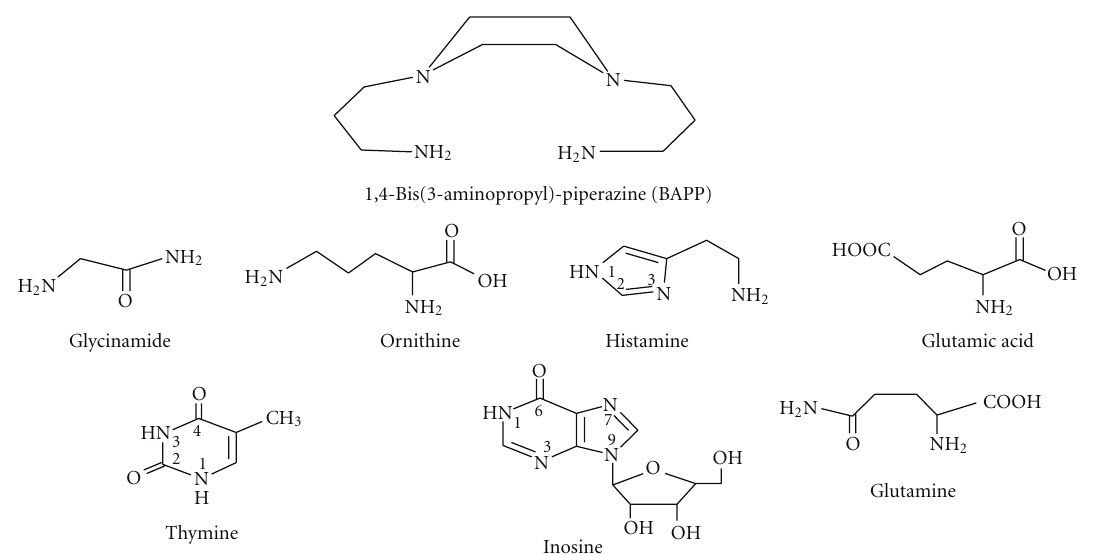
Scheme 1: Structural formulae of some important investigated ligands.